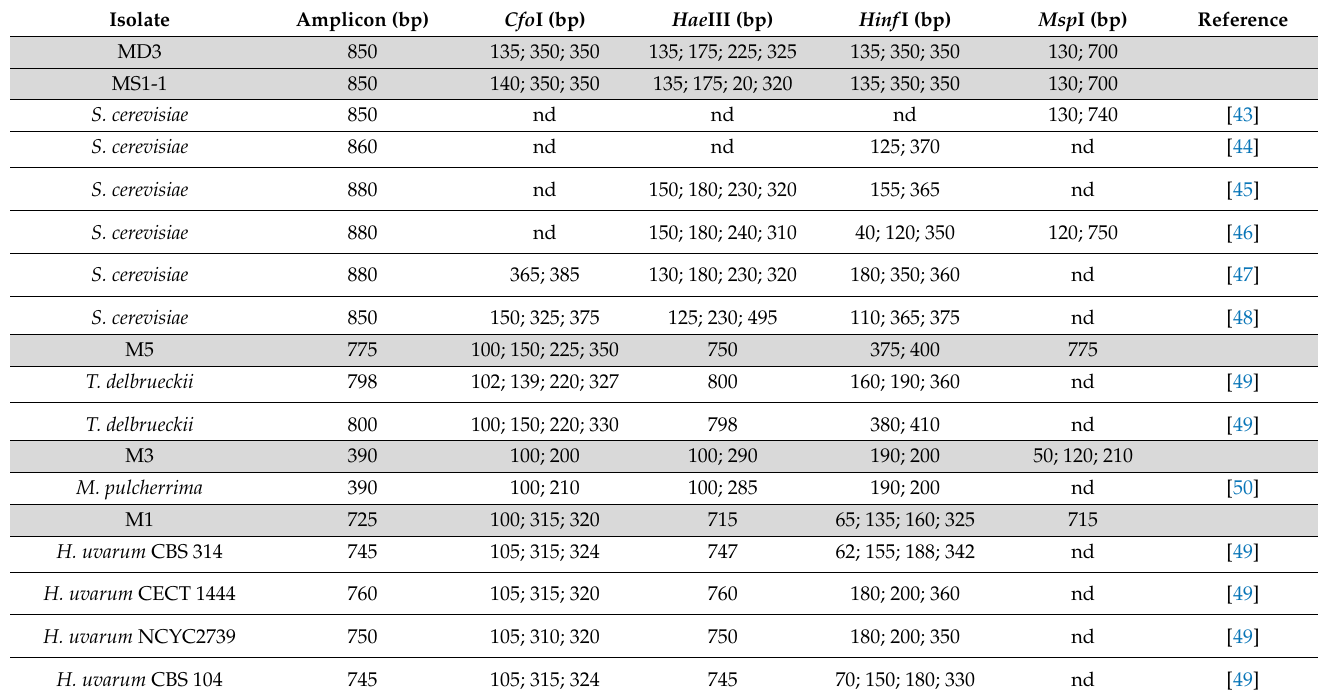
Table 3. Size of amplicons and restriction fragments obtained for the ITS1-5.8S-ITS2 region for yeasts isolated from wine wort and species of interest described in the literature (nd: not